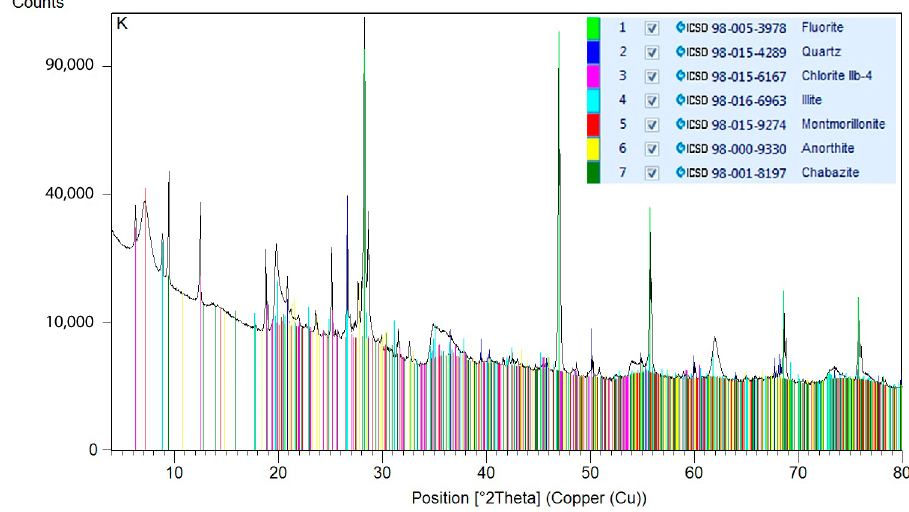
Figure 4. Diffractogram of Bentovet K.